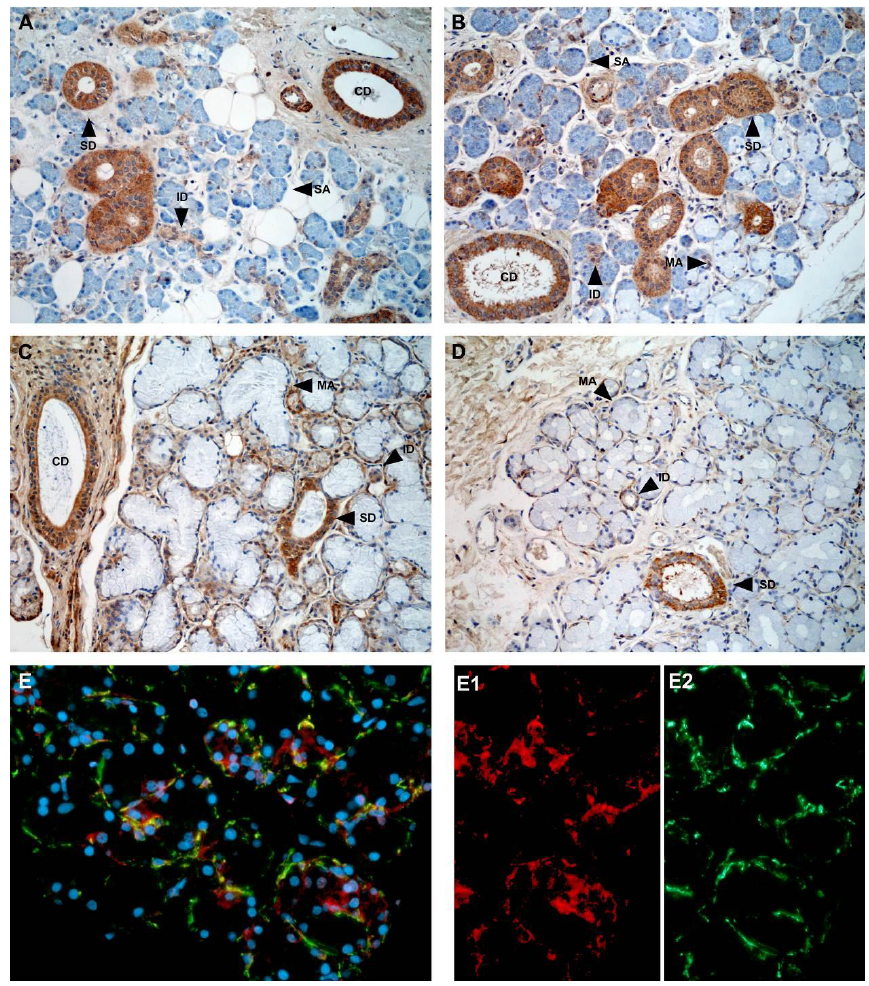
Figure 2. Immunohistological expression of pro-nerve growth factor (pro-NGF) in salivary glands.